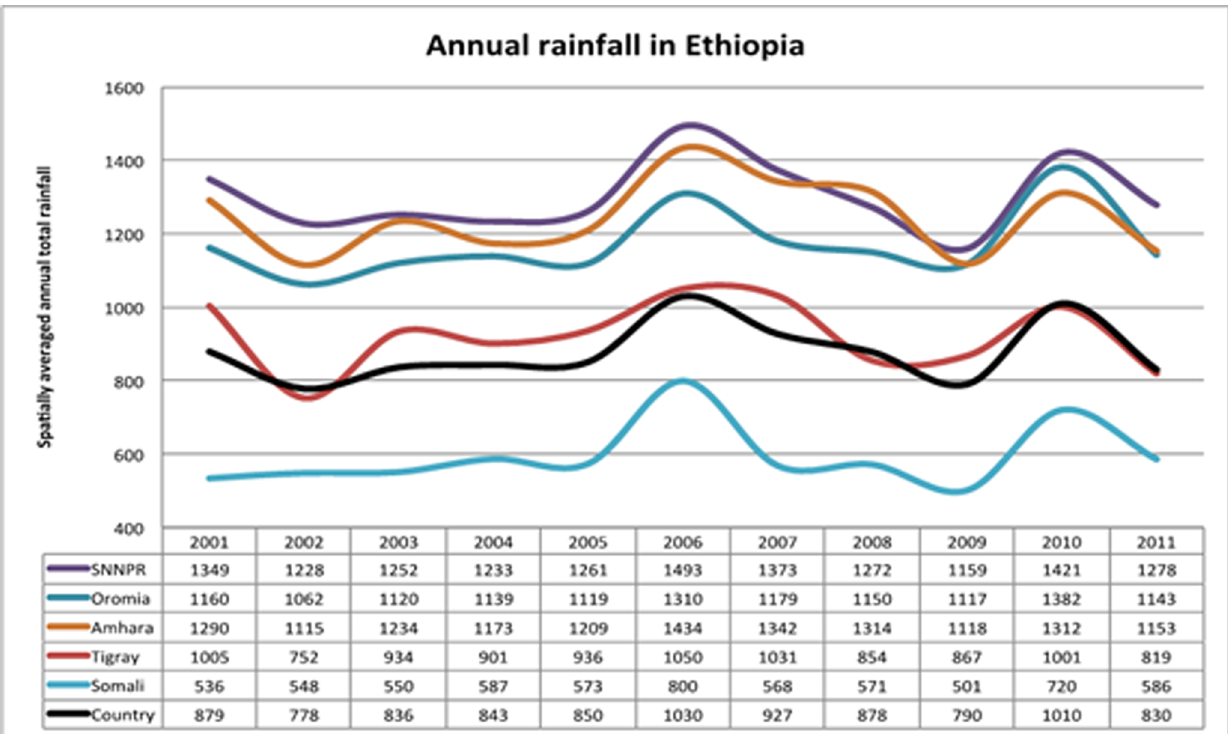
Figure 7. Trends of annually averaged rainfall (mm) in the major regions, 2001–2011, Ethiopia.